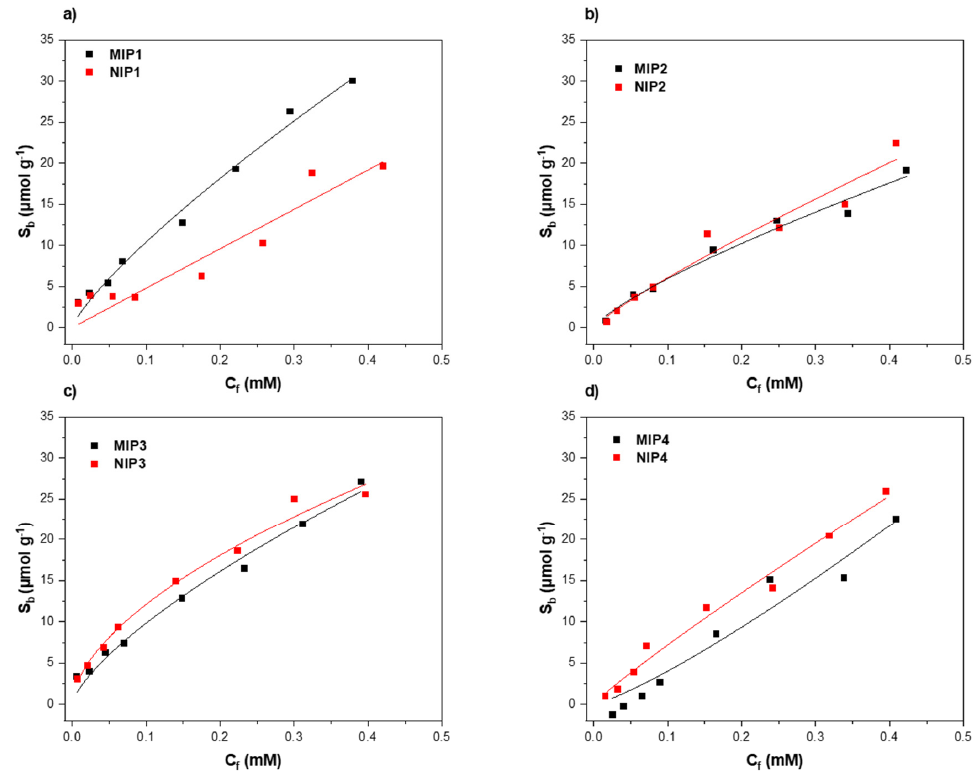
Figure 2. Rebinding analysis with UV–VIS spectroscopy of ( a ) MIP/NIP1, ( b ) MIP/NIP2, ( c ) MIP/NIP3, and ( d ) MIP/NIP4.